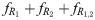
The mixing strategy for estimated resistance frequencies.For each data point, its location on the X axis represents the predicted ratio of incorrect treatment under mix3 relative to mix2 according to our model, and its location on the Y axis represents the predicted ratio of triple resistance emergence. A red line is drawn where the strategies inhibit triple resistance equally well, so below the line mix3 reduces both incorrect treatment and triple resistance emergence more efficiently than mix2. Panels A and B present the results of the models without community feedback and with it, respectively. Antibiotic resistance frequencies among incoming patients are estimated from data (see Methods and S1 Table). The color indicates the estimated resistance frequencies to the common antibiotics (fR1+fR2+fR1,2). The system is simulated for 20 years and the rest of the parameters are as in Fig 2.